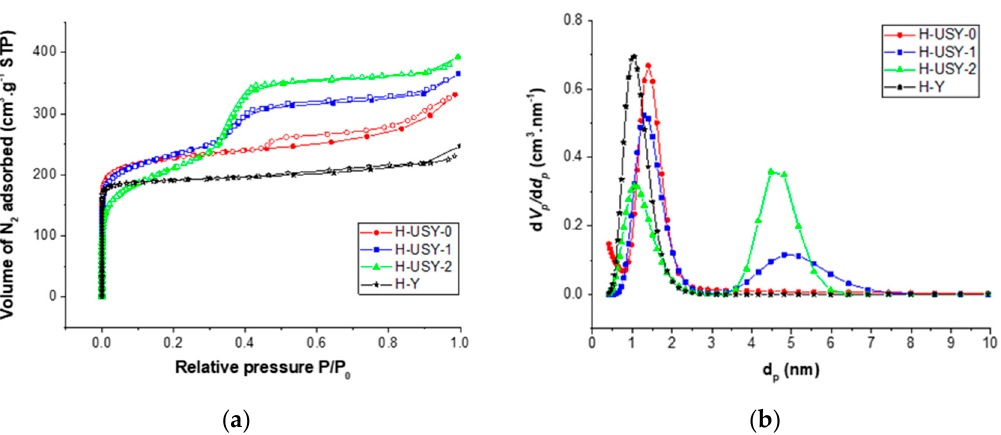
Figure 2. ( a ) N 2 adsorption-desorption isotherm at 77 K. ( b ) The pore size distribution derived from the NLDFT method applied to the nitrogen adsorption isotherms.